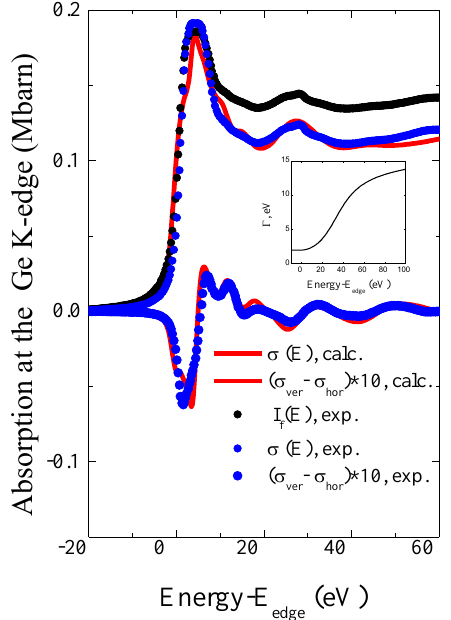
Figure 3. Black dots are the experimental fluorescence spectrum I f (E) due to excitation of the 1s Ge level, blue dots are the absorption spectrum obtained after correction to the self-absorption effect and the linear dichroism spectrum. Red lines are the resonance part. The inset shows the dependence of the full width of the electron–hole stat еГ ( E ) on energy used in the calculations. E edge = 11,113.8 eV.